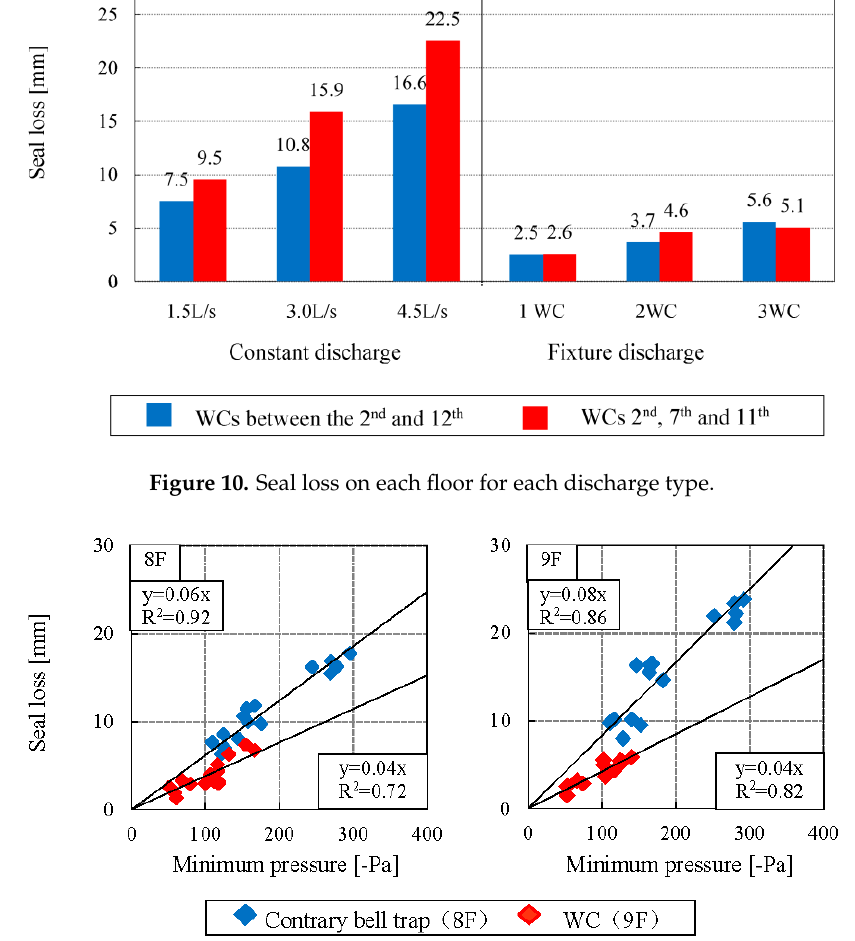
Figure 11. The scatter diagram and primary regression equation for the minimum pressure in the pipe and the seal loss in each load type. Table 5. Regression coefficient a and the ratio of regression coefficient of the constant discharge to the fixture discharge α.